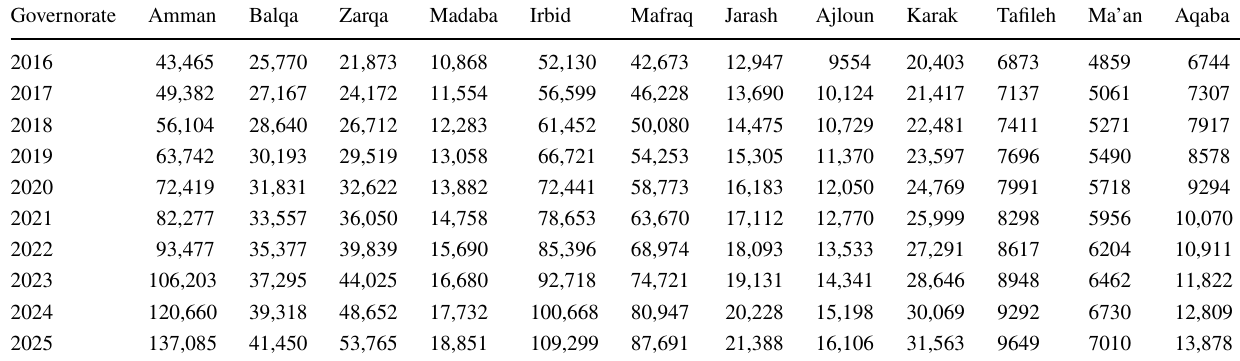
Table 2 Forecasted number of houses and villas in each governorate from 2016 to 2025 Governorate